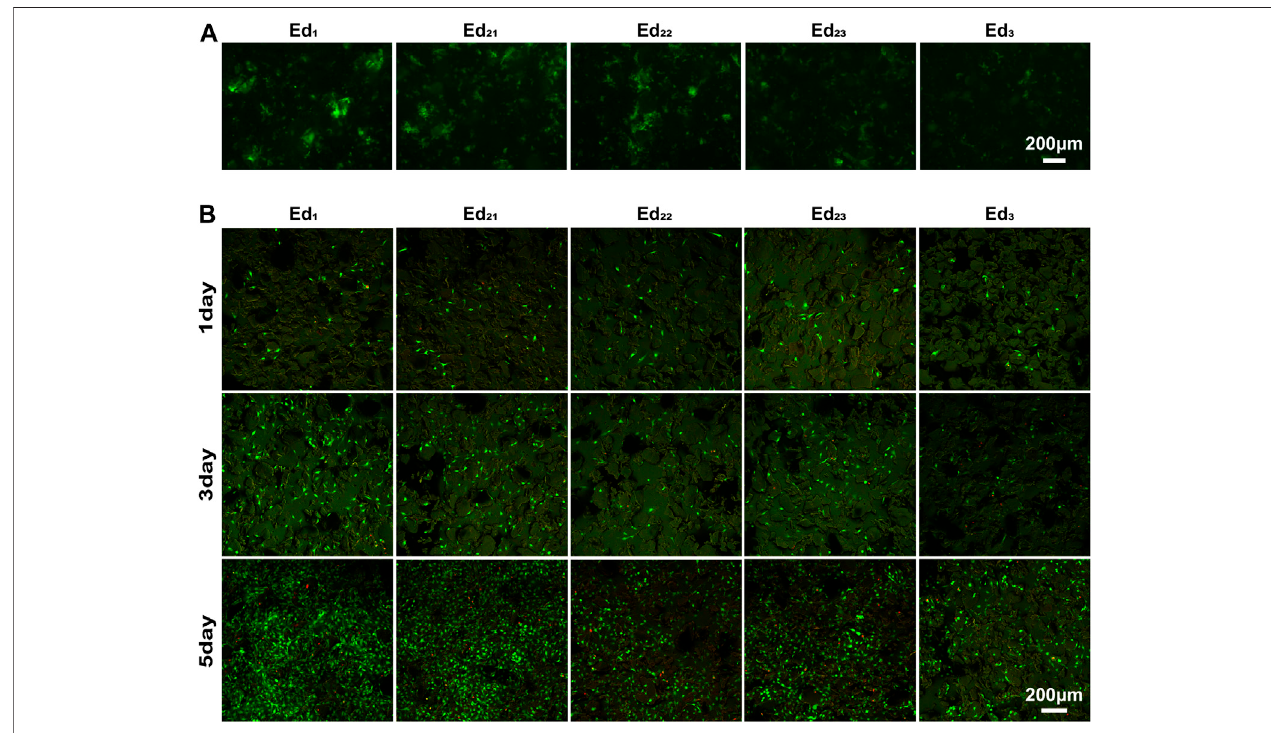
FIGURE 6 | Qualitative analysis of in vitro biological properties of scaffolds. (A) Fluorescence images of GFP adsorption on the surface of scaffolds after 24 h. (B) Confocal laser images of MC3T3-E1 cells growing on the surface of scaffolds for 1, 3, and 5 days after live/death staining.